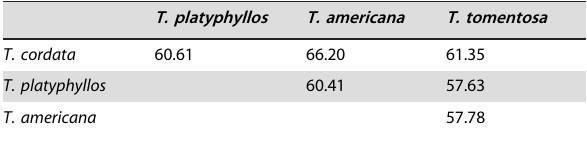
Non-tooth features (mean accuracy: 60.7%)